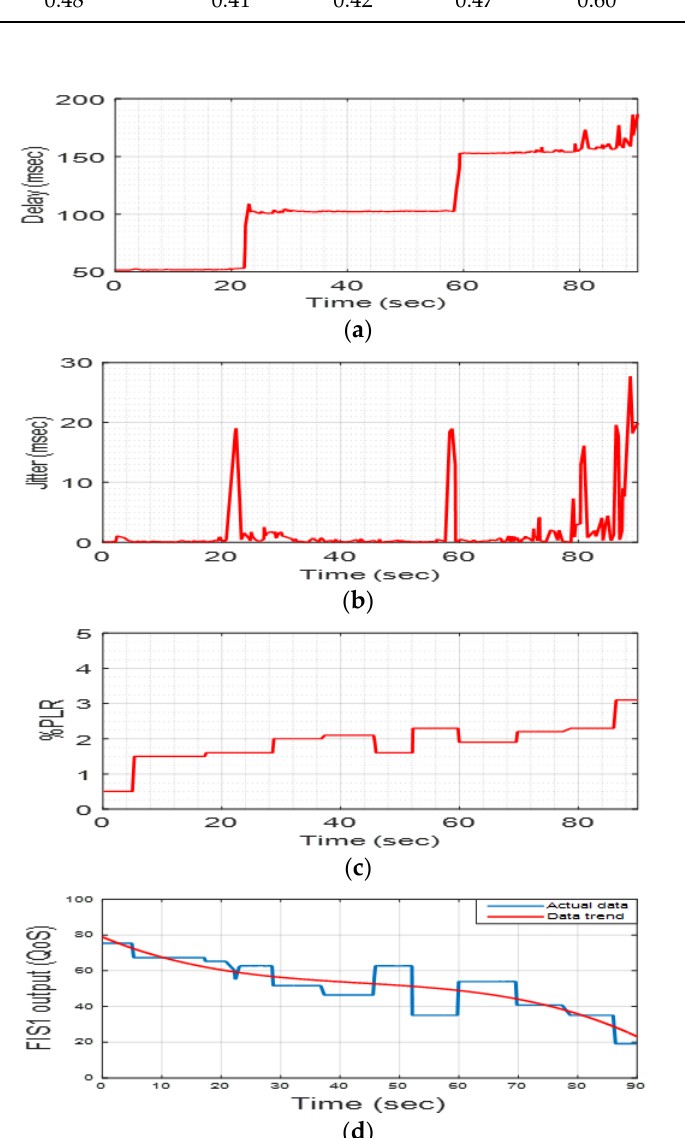
Figure 10. ( a ) Traffic delay, ( b ) jitter ( c ) percentage packet loss ratio (%PLR) and ( d ) quality of service (QoS) obtained from FIS1.